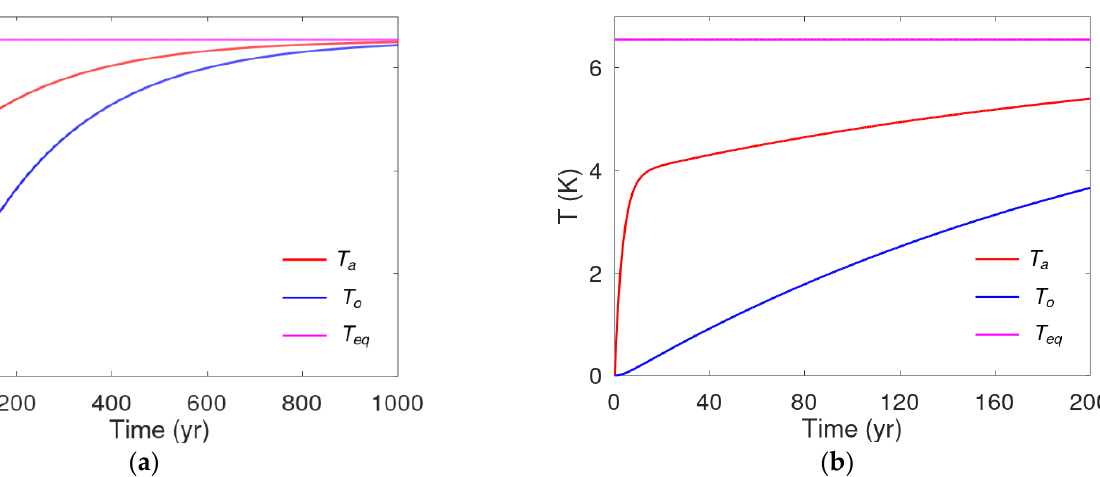
Figure 1. Global mean surface temperature (red line), global mean deep ocean temperature (blue line) and the equilibrium temperature (magenta line) calculated for step-forcing: ( a ) over time interval of 0–1000 years, ( b ) zoomed shape over time interval 0–200 years.